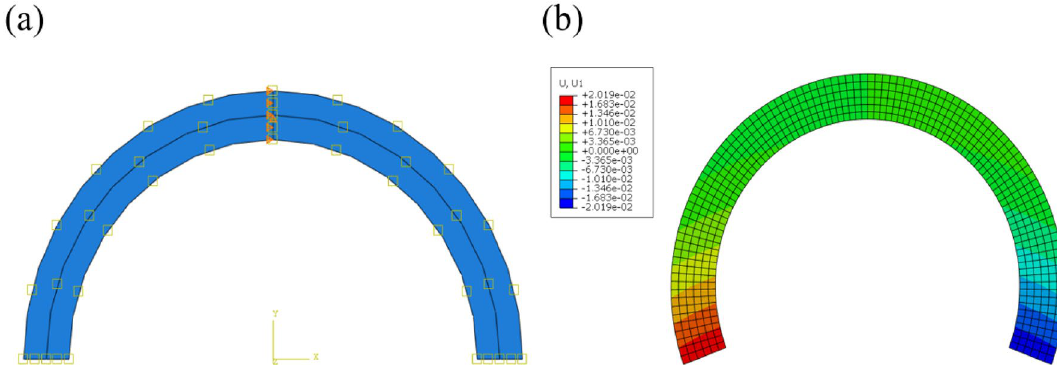
Figure 3. Finite element model: ( a ) initial state; ( b ) contour plots of displacement along x